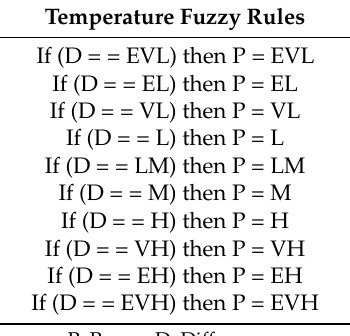
Table 3. Fuzzy rules for the temperature fuzzy